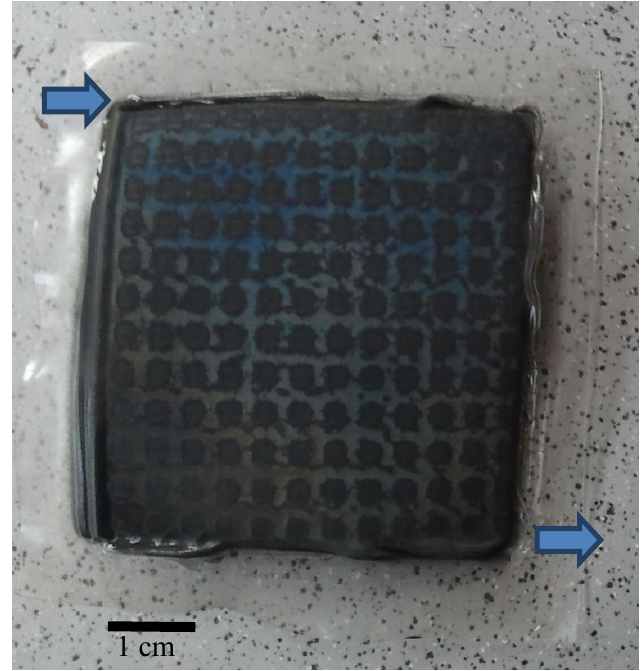
Figure 6. Photograph of TiB electrode after fuel cell test. Iridescent blue regions close to 2 the oxygen inlet ( top left ) indicate where titanium diboride has been transformed into titanium oxide. At the oxygen outlet ( bottom right ), orange colors